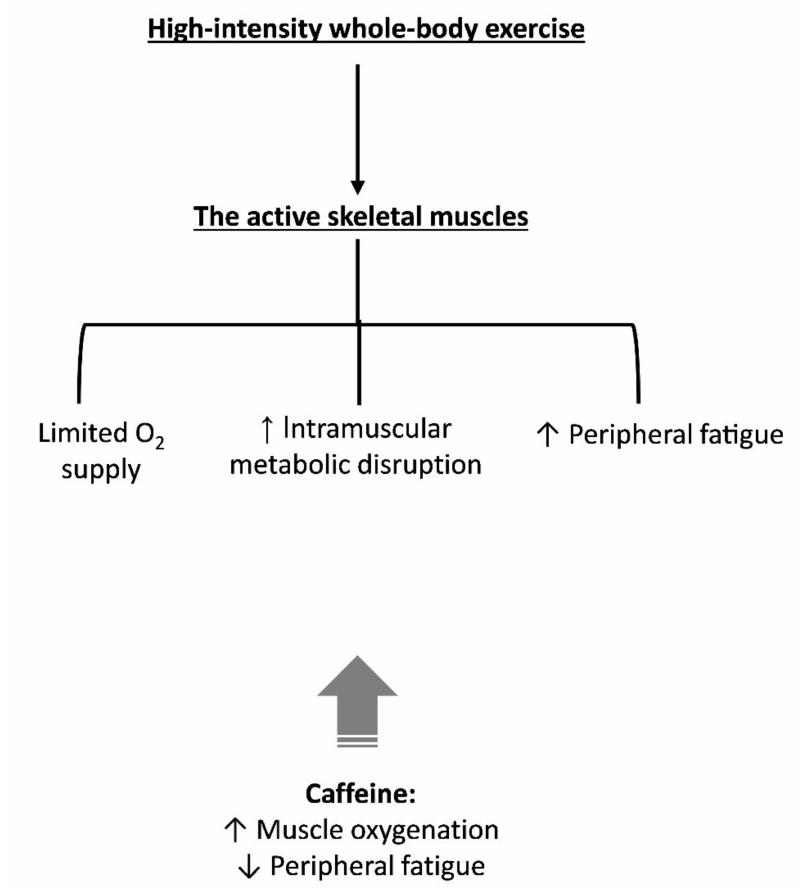
Figure 5. Main physiological events within the skeletal muscle system that might contribute to fatigue during high-intensity whole-body exercise. The potential influence of caffeine on components of the skeletal muscle system that might explain part of its ergogenic effect is also indicated.